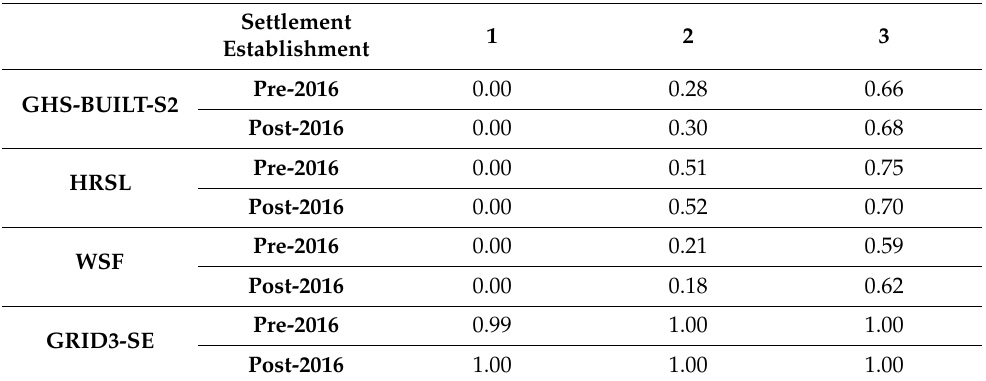
Table 4. Portion of each settlement product’s contribution to areas with single or multi-product agreement for settlements established pre- or post-2016. All four products have 100% contribution to locations where four products are in agreement; not shown in table. GHS-BUILT-S2, Global Human Settlement Layer with Sentinel 2; HRSL, High Resolution Settlement Layer; WSF, World Settle- ment Footprint; GRID3-SE, Geo-Referenced Infrastructure and Demographic Data for Development settlement extent data.